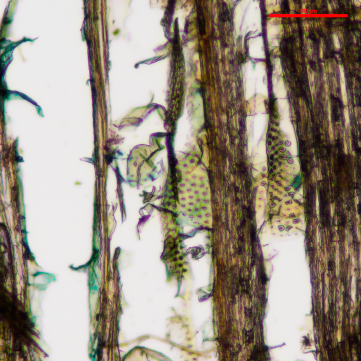
Figure 3. Radial section of a willow showing alternate vessel wall pitting and Chlorociboria spp. pigmentation. Magnification 200×.